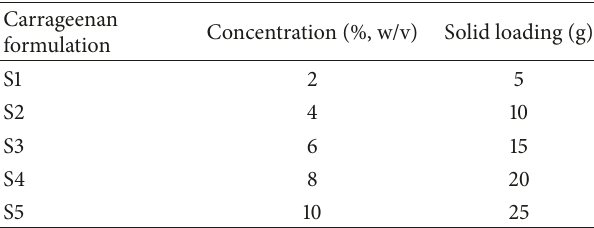
Table 1: Five different formulations of carrageenan solution using completely randomized block design (CRBD)